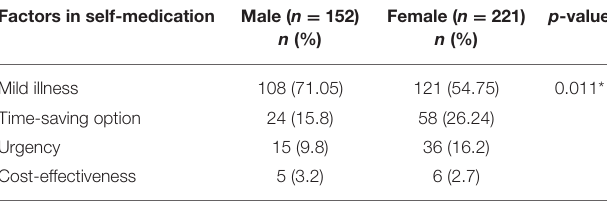
TABLE 4 | Factors in self-medication ( N =